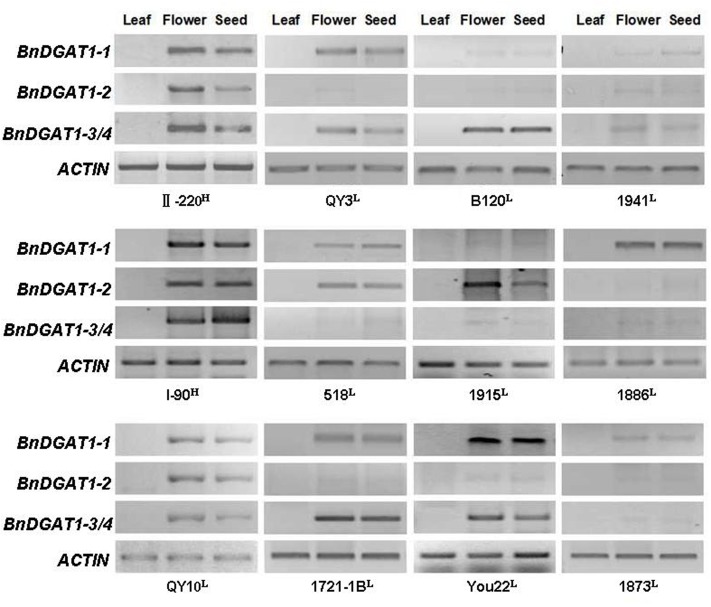
Expression patterns of BnDGAT1s in leaves, flowers, and developing seeds of B. napus. Tissue samples were collected on 28 DAP and analyzed by RT-PCR. Actin was used as internal reference. Primers and semi-quantitative PCR conditions are described in Section “Materials and Methods.” L indicates low seed oil and H indicates high seed oil.